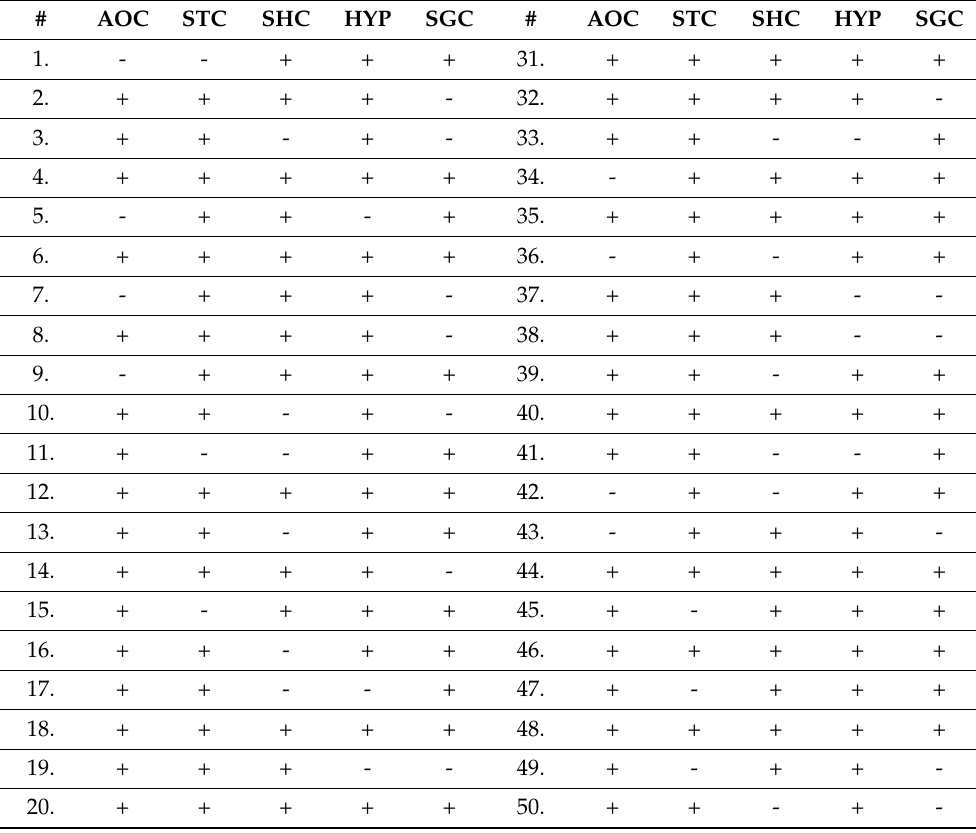
Table A1. Representation of metabolic syndrome parameters in the tested